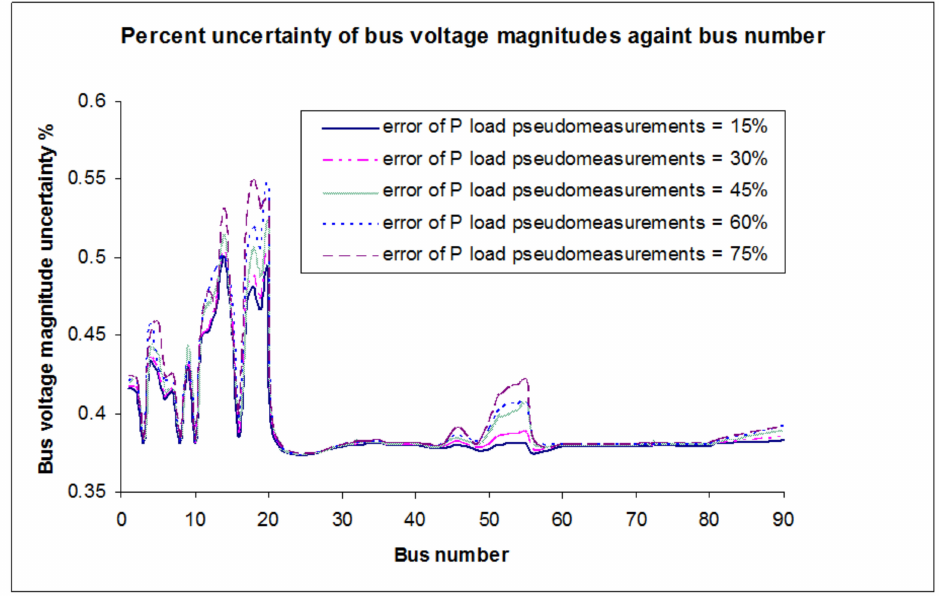
Figure 6. Bus voltage magnitude uncertainties with regard to errors in active load pseudo- measurements.